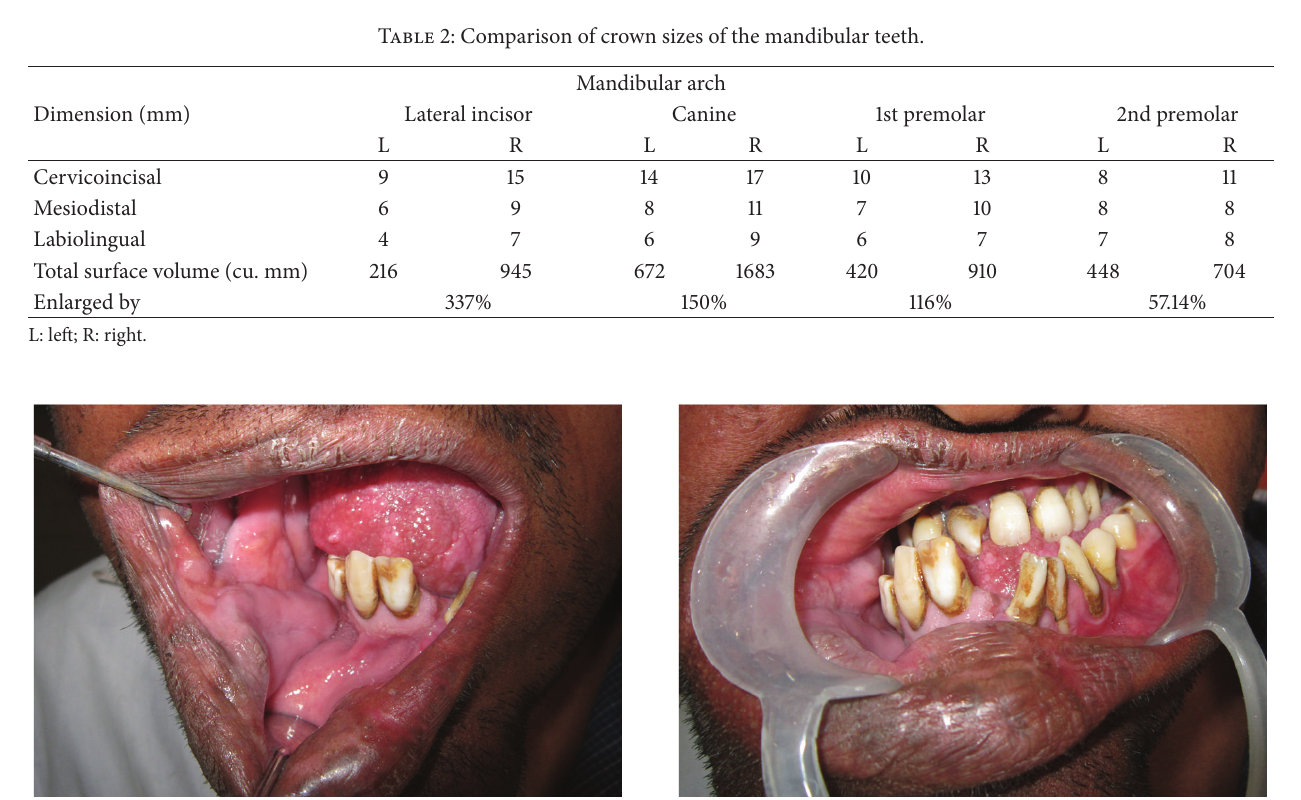
Figure 5: Intraoral photograph showing major variability between crown sizes of the teeth on the right and the left side with generalised crossbite